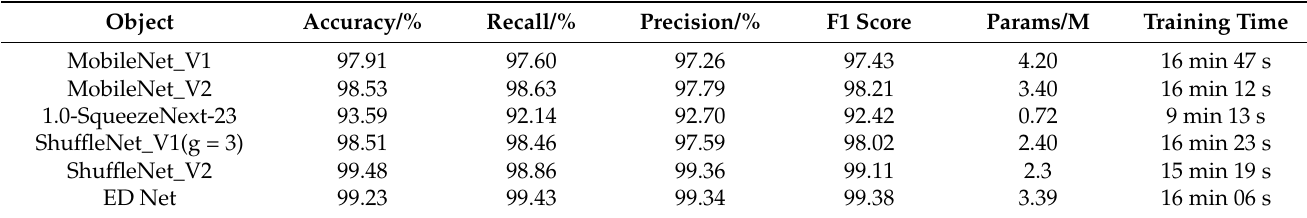
Table 5. Comparison of experimental results of common lightweight